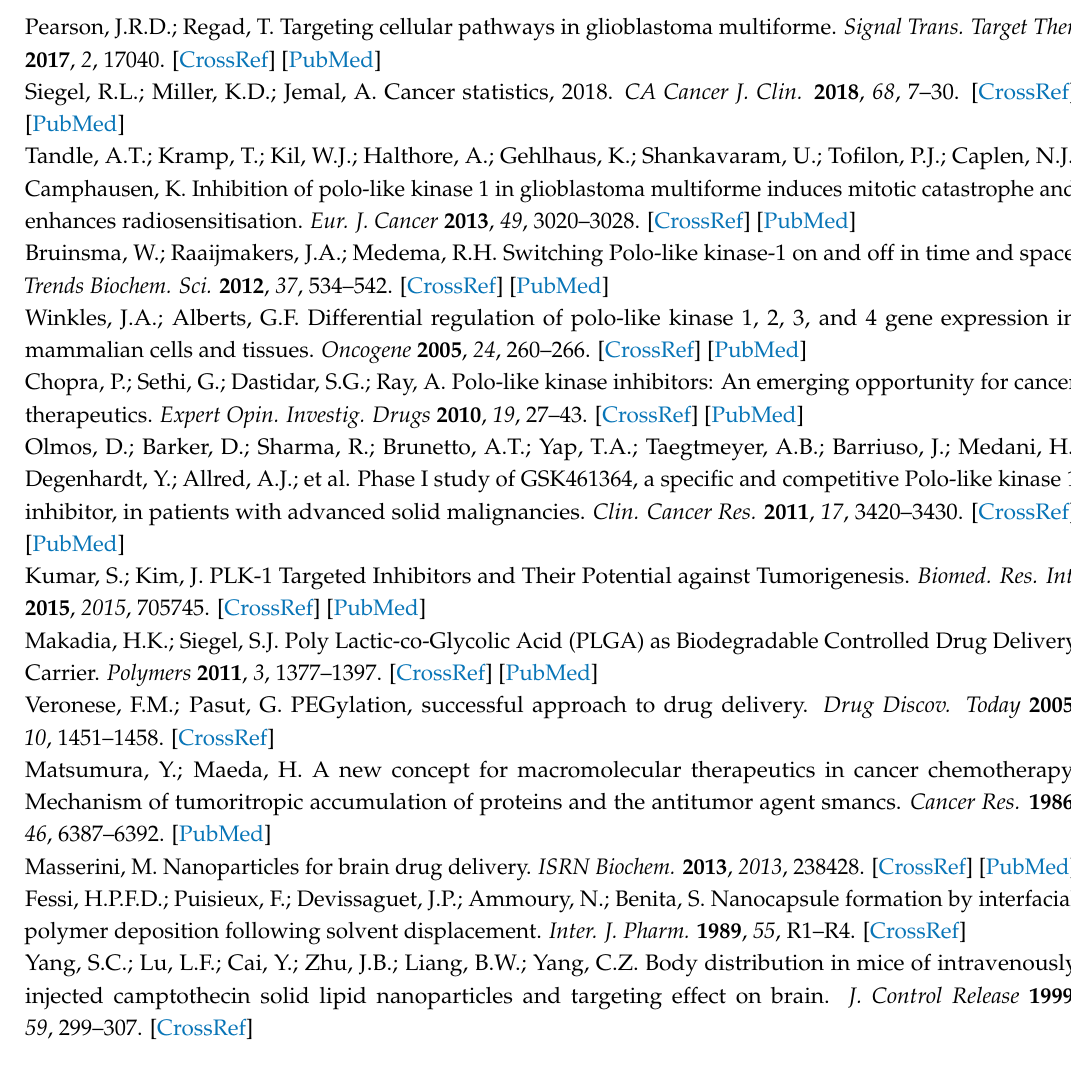
Figure S1: UV spectrum of GSK461364. (1A) Maximum wavelength ( λ max) observed at 272 nm and 305 nm when dissolved in ethanol (1B) λ max observed at 311 nm when the drug is dissolved in 1% triton-x; Figure S2: EC50 curve of GSK461364 in U87-MG cell line: The graph plots % cell viability on the Y-axis when dosed with concentrations (X-axis) from 1 picomolar to 17 µ M of GSK. Fit was done using dose-response simulation in Dr Fit© using the biphasic fitting type with two inflexion